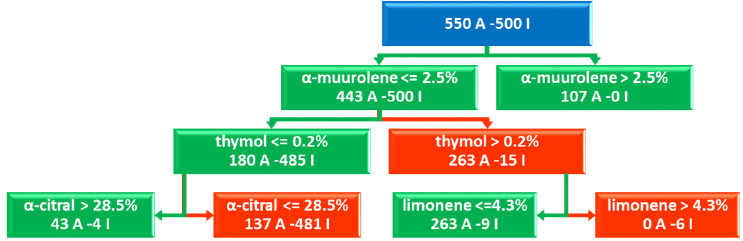
Figure 1. Top 3 levels of the RF first decision tree: most important chemical components from the DA dataset on M. canis bioactivities and EO virtualized chemical composition. The full tree is reported as Supplementary Figure S1. Green path indicates positive impact on M. canis inhibition, while red path, negative influence. The blue box indicates the starting DA dataset composition. In this tree limo-nene, linalool, and sabinene are indicated to be important but at low concentrations (lower than 0.6%, 8.9%, and 0.1%, respectively).